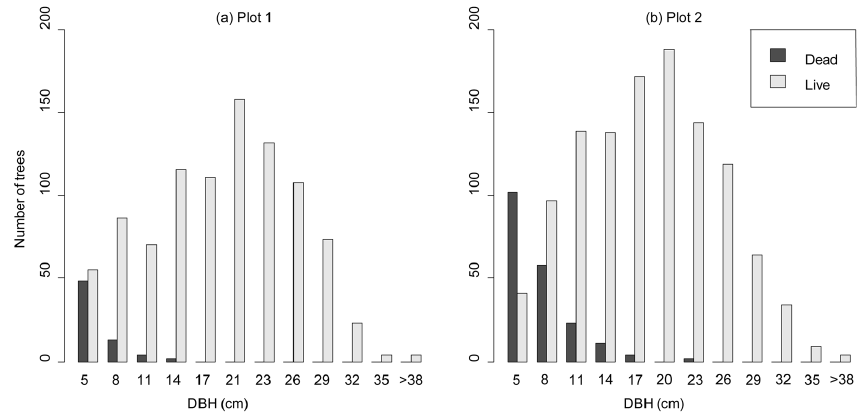
Figure 3. Tree DBH size distributions for plots 1 ( a ) and 2 ( b ). Black areas represent dead trees and grey areas represent live trees.